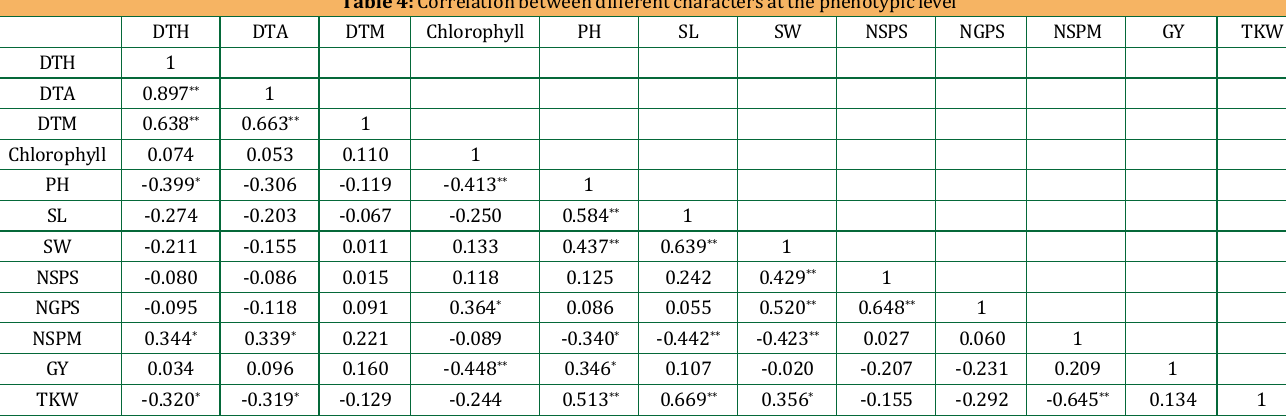
Table 4: Correlation between different characters at the phenotypic level